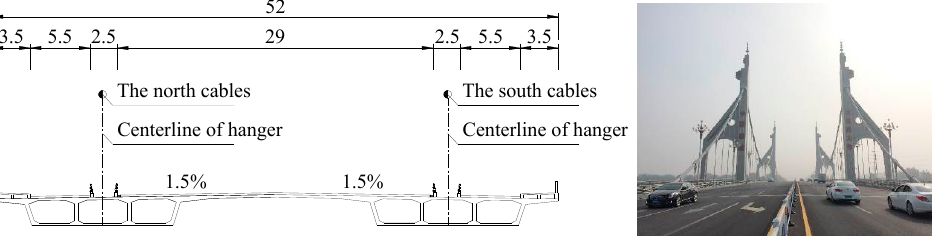
Figure 2. Cable system and extra-wide girder (Unit: m).